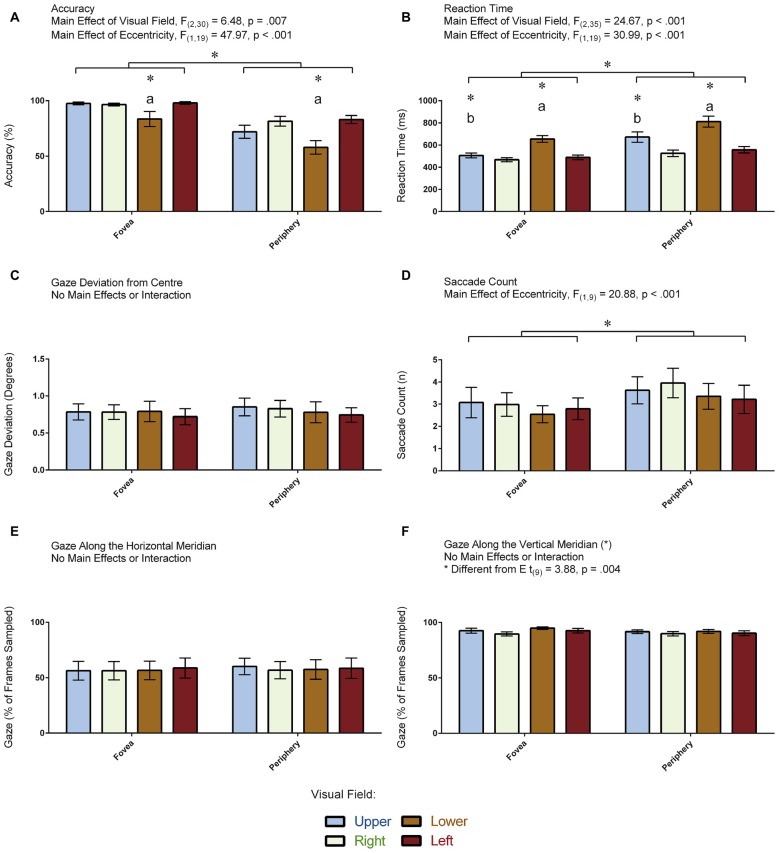
Results for the visual-field experiment. The figure depicts the means and standard errors (SEM) for each condition for each of the following dependent variables: (A) accuracy (% correct); (B) reaction time (ms); (C) gaze deviation from center (degrees of visual angle); (D) saccade count (n); (E) gaze along the horizontal meridian (% of frames sampled); and, (F) gaze along the vertical meridian (% of frames sampled). All asterisks (*) denote significant differences after corrections were applied for multiple comparisons (pcorr < 0.05). Labeled asterisks (*) denote differences from: (a) the upper, right and left visual fields for that eccentricity condition; and, (b) the lower, right and left visual fields for that eccentricity condition.